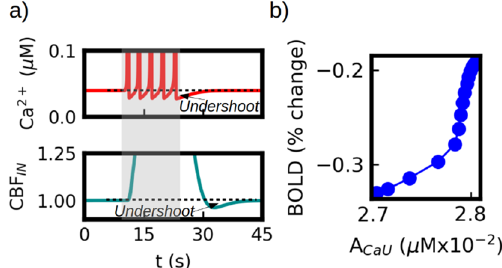
Figure 6. Calcium effects in BOLD post-stimulus undershoot. ( a ) Top panel: calcium time course during stimulation. After the stimulus is removed the calcium signal remains below its basal level and slowly recovers (indicated as Undershoot in the figure). The depressed calcium level leads to a post-stimulus undershoot in the blood flow (CBF IN ) which is shown in the bottom panel. ( b ) Evolution of the BOLD undershoot amplitude as a function of the calcium undershoot amplitude. We see that the changes in the calcium level lead to a variation of 50 % in the BOLD